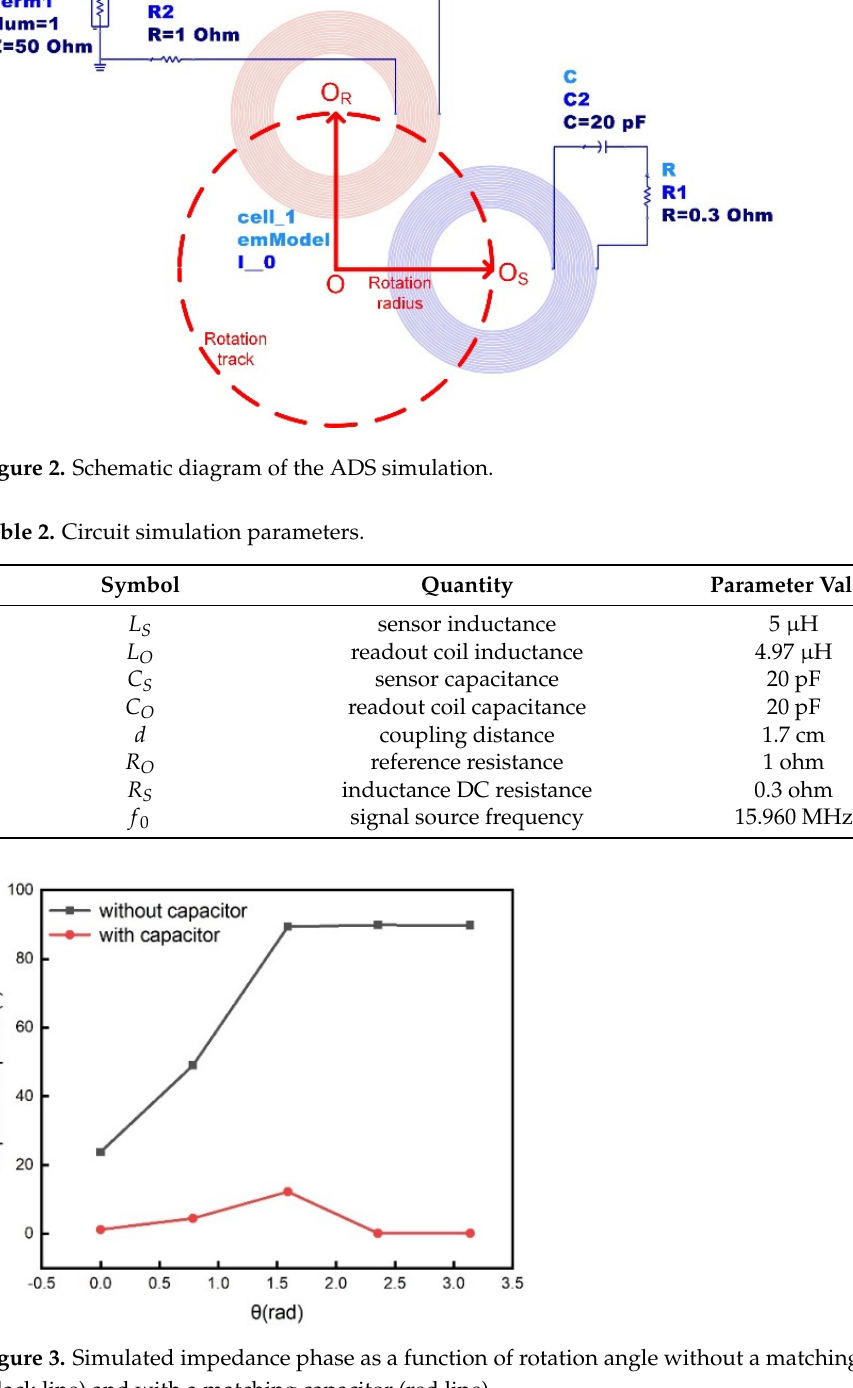
Figure 3. Simulated impedance phase as a function of rotation angle without a matching capacitor (black line) and with a matching capacitor (red line).